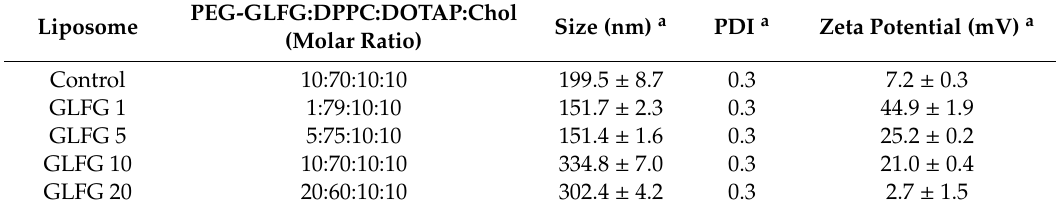
Table 1. Characterization of GLFG